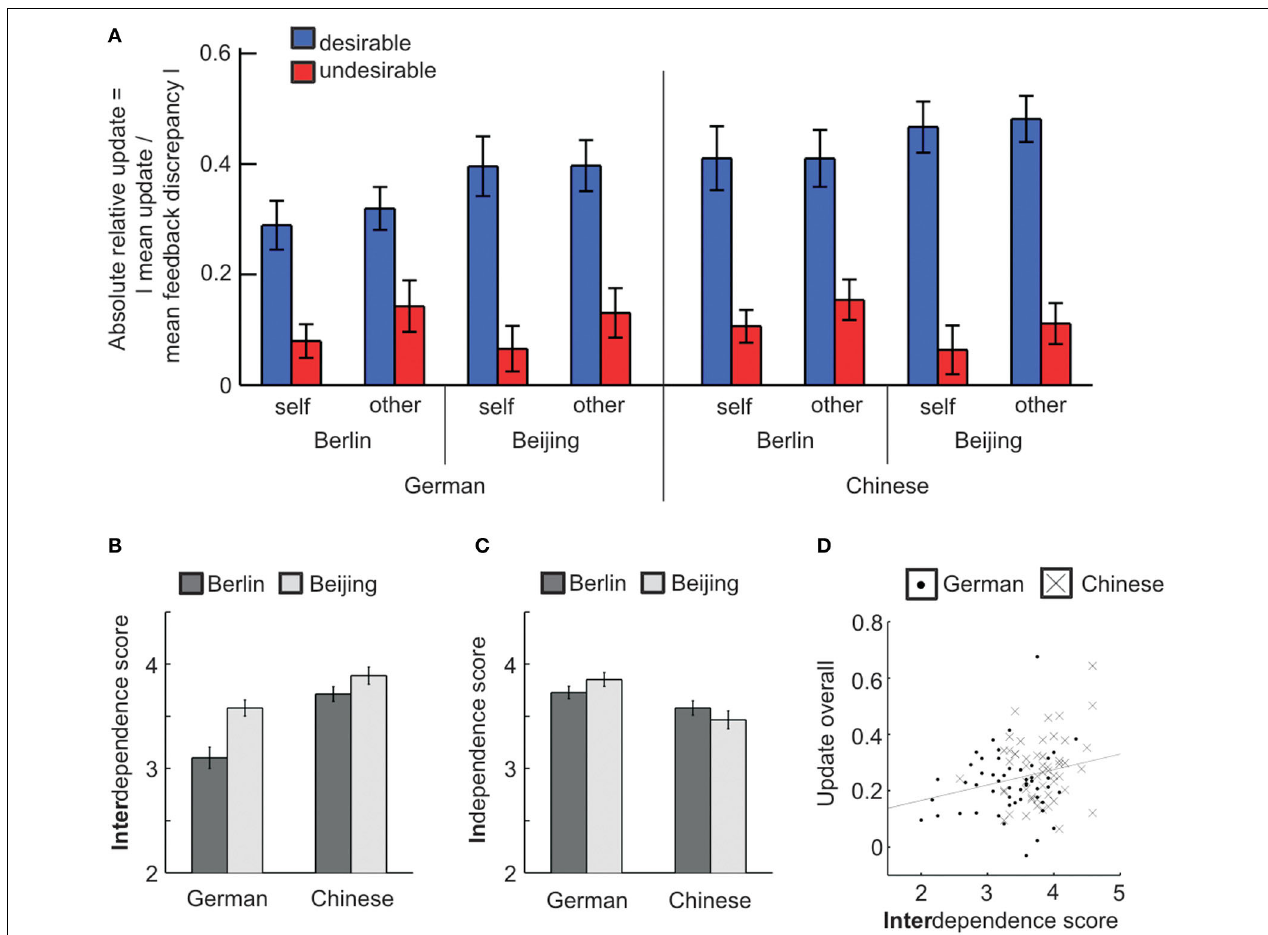
FIGURE 2 | Behavioral results—cultural difference in overall updating and cultural similarity in positively biased updating. (A) Overall Chinese showed greater updating than Germans. Positively biased updating was evident across all participants, i.e., updates were higher for desirable compared with undesirable feedback. Additionally, relative absolute mean updates were higher for